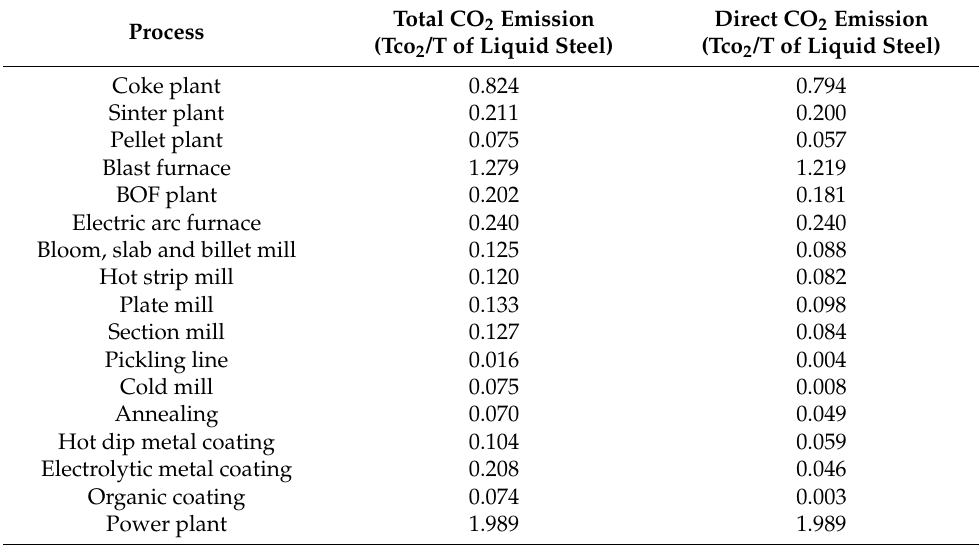
Table 1. Average CO 2 emissions per tonne of product for the Iron & Steel production in Europe